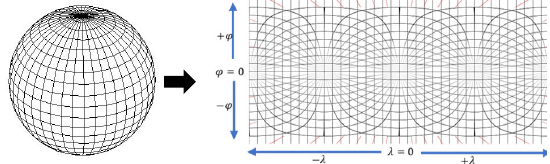
Figure 1. Points projected from 3D space into the 2D panorama equirectangular image. Therefore, every point in the equirectangular panorama has a latitude (vertical angle) and longitude (horizontal angle) coordinates. The horizontal and vertical angles are used to solve the pose of the equirectangular panorama by space resection. However, the resection model is nonlinear and sensitive to initial values that should not be far by more than 1' to have a proper convergent solution (Shepherd 1982, Schofield 2007, Alsadik 2016). On the other hand, when a frame camera is used, then the collinearity resection model is used. Collinearity is considered as the standard mathematical model in photogrammetry